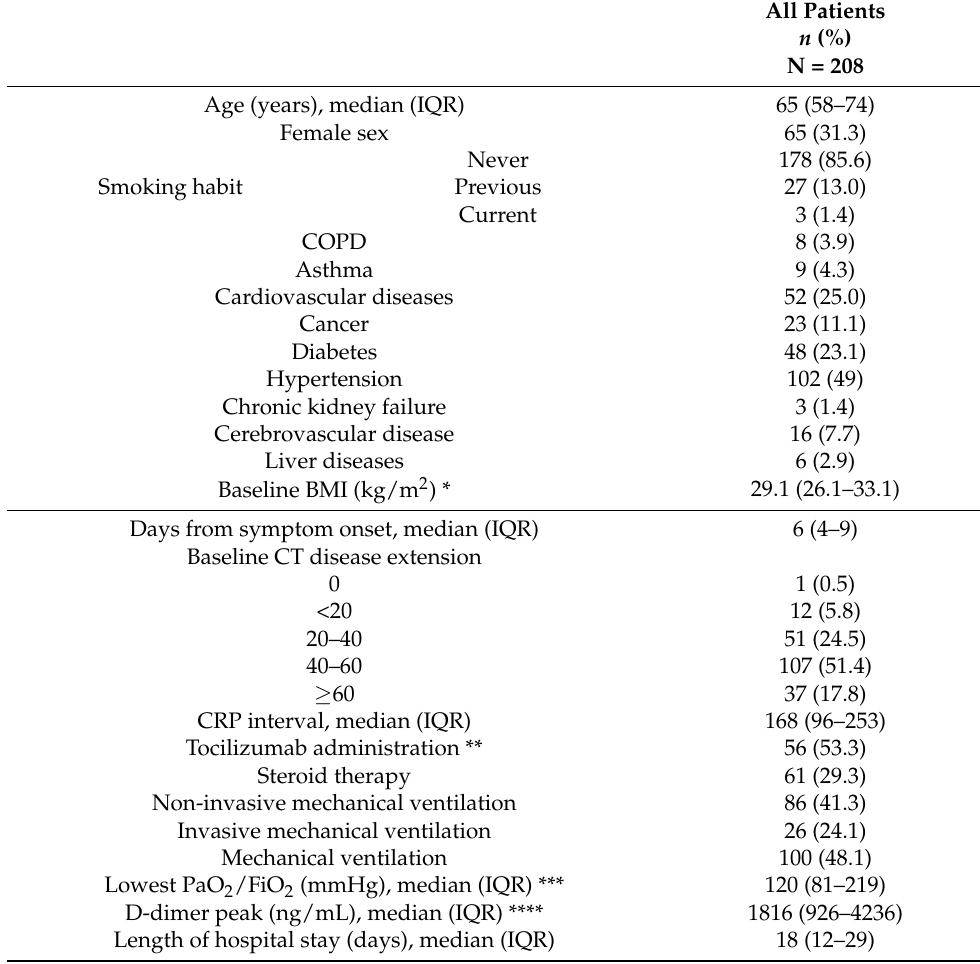
Table 1. Baseline clinical characteristics and COVID-19 severity measures of the included